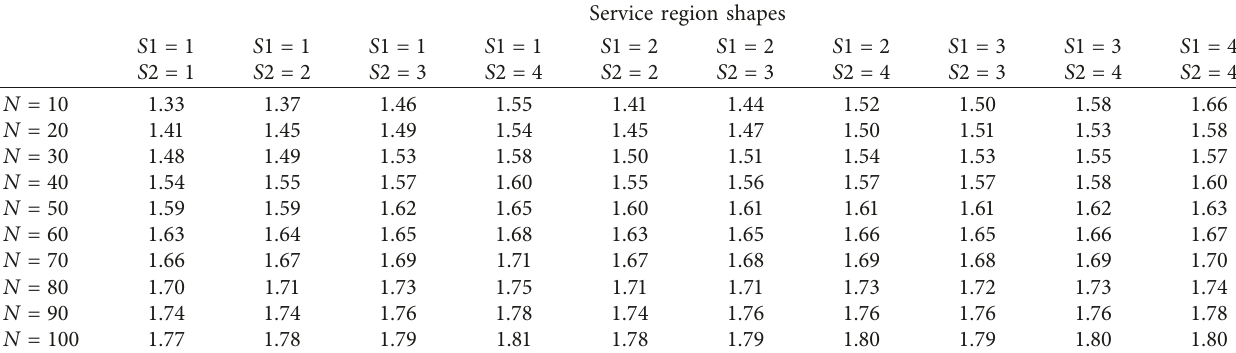
Figure 7: Scatterplot of the expected length of the shortest path and Table 5: Ratio of L to